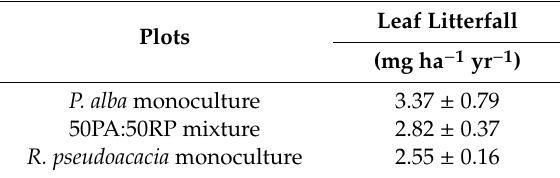
Table 2. Leaf litter total annual weight in P. alba or R. pseudoacacia monocultures and 50PA:50RP mixture